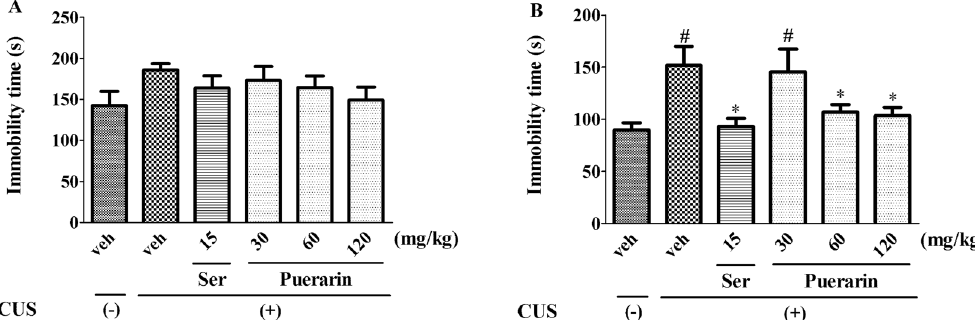
Figure 4. Puerarin attenuated the CUS-induced behavioral deficits in FST. # p < 0.05 vs. vehicle-treated CUS ( − ) group; * p < 0.05, ** p < 0.01 vs. vehicle-treated CUS ( + ) group (n = 10 per